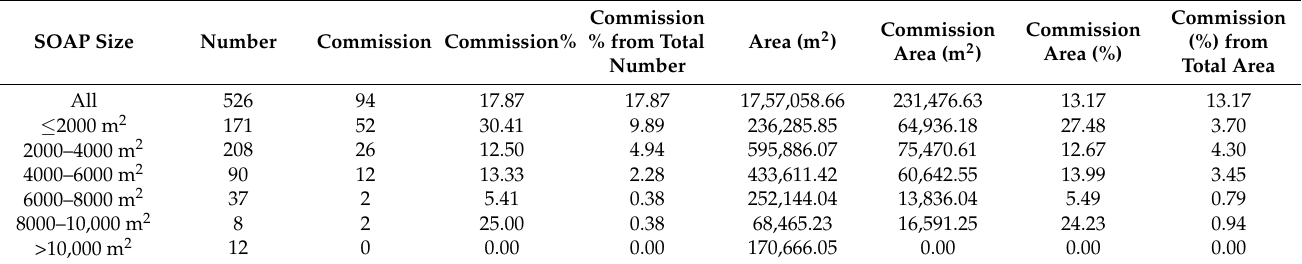
Table 3. Commission error evaluation from the comparison between extracted and labeled SOAPs. The statistics show the number of SOAPs (and their areas) extracted from the proposed method while labeled as background, for different SOAP size